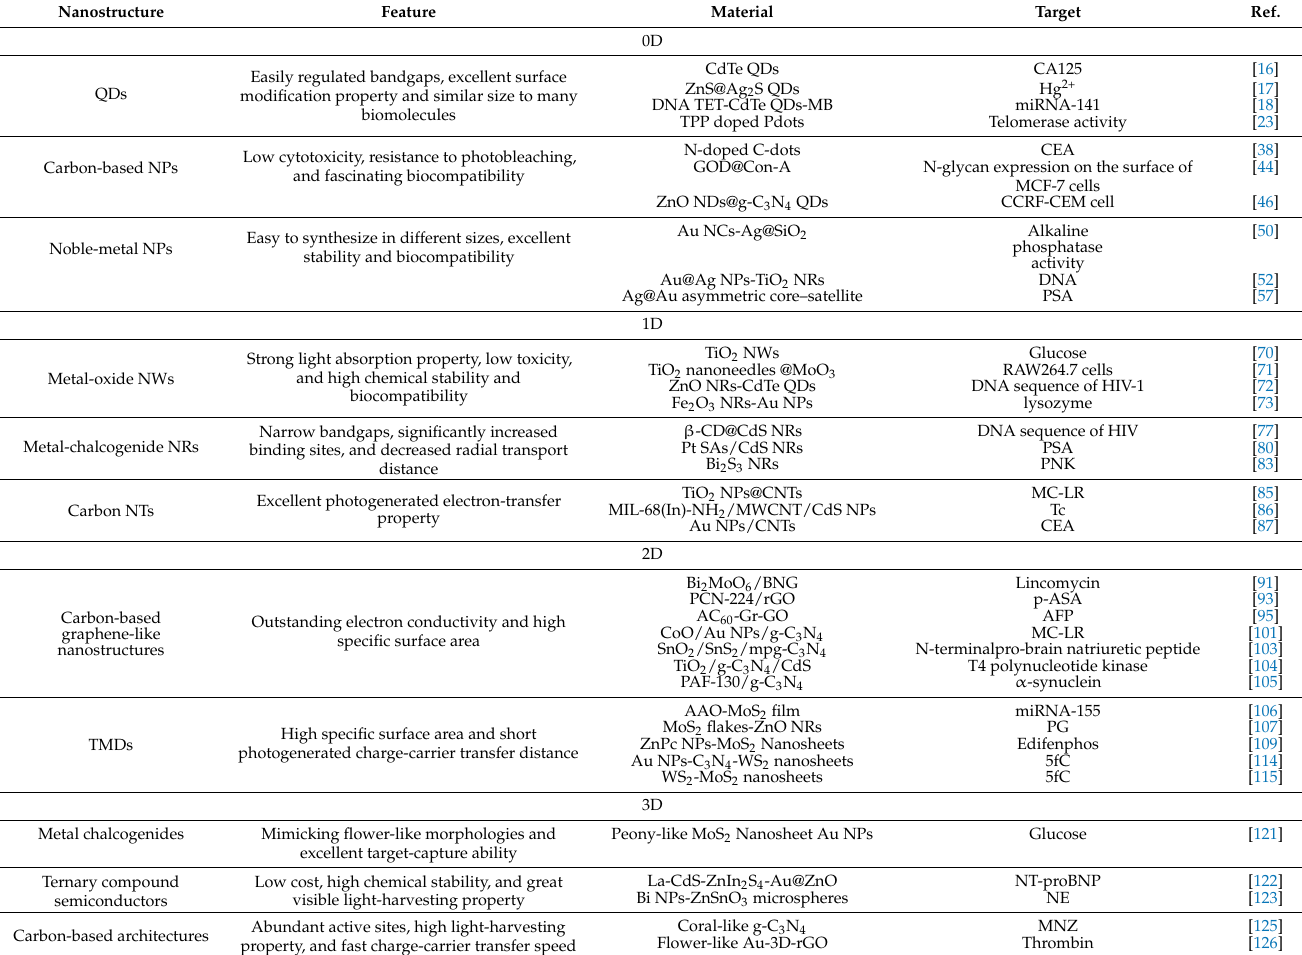
Table 1. Summary of representative nanostructure materials for PEC analysis discussed in this